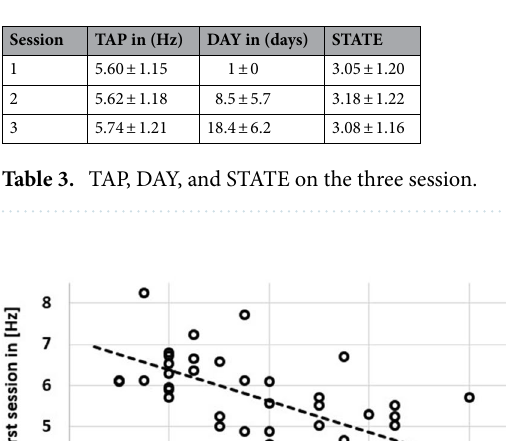
iterations to give credible and confidence intervals of the significance levels of the model’s factors. Homogeneity of variance in TAP was examined for the first session for SEX, HAND, TRIAL, and LAT, and for SESSION by Fligner–Killeen’s tests. Further, TAP and STATE were checked for normal distribution by a chi-squared test due to data ties (but no estimate of rounding difference 35 ). A post-hoc estimation of statistical power for the TAP model was computed by a simulation with 1000 iterations based on the intercept, coefficients (fixed effects), and variance (random effects) of our data. For each iteration, analyses of variance comparing the models with and without the respective factors were run. Power was given by the probability of p < 0.05. Additional bivariate correlations between the mean tapping frequency in the first session and the EDSS, as well as between tapping frequency and (adjusted) reported day forms were computed in order to display the practicability and robustness of the tapping test. Variance inflation (VIF) was set to VIF < 5.0. α was set to 0.05. Statistics were run in RStudio (RStudio Inc.).